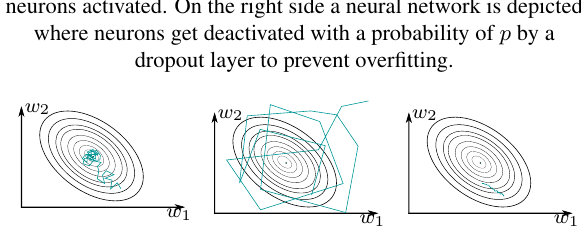
Figure 4. Influence on the convergence of the optimization using the SGD. The figure on the left side shows how the convergence of a 2D optimization should look like for a fitting LR. A LR to high will lead to a divergence of the optimization as shown in the figure in the middle. In the figure on the right the LR is too low what results into a convergence towards a local minimum.